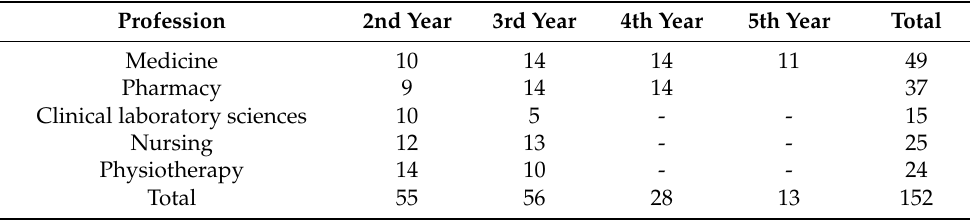
Table 1. Student distribution per profession and academic year.